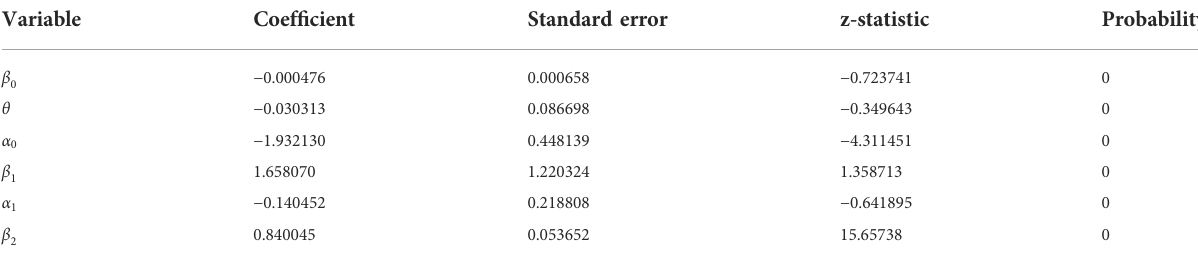
TABLE 5 Parameter estimates of CEA bene fi t sample for July 2021 - December